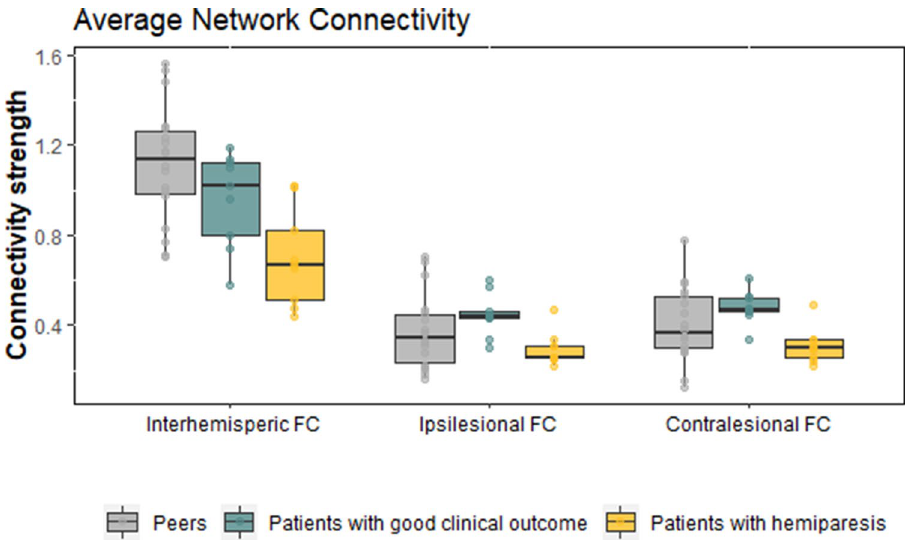
Figure 2. Between-group differences in motor network connectivity between patients with hemiparesis, patients with good clinical outcome, and typically developing peers. Patients with hemiparesis displayed significantly lower interhemispheric network connectivity than typically developing peers. Patients with good clinical outcome displayed significantly higher intrahemispheric network connectivity in the ipsilesional and contralesional hemisphere. Error bars show the standard error of the mean; (FC) = functional connectivity.